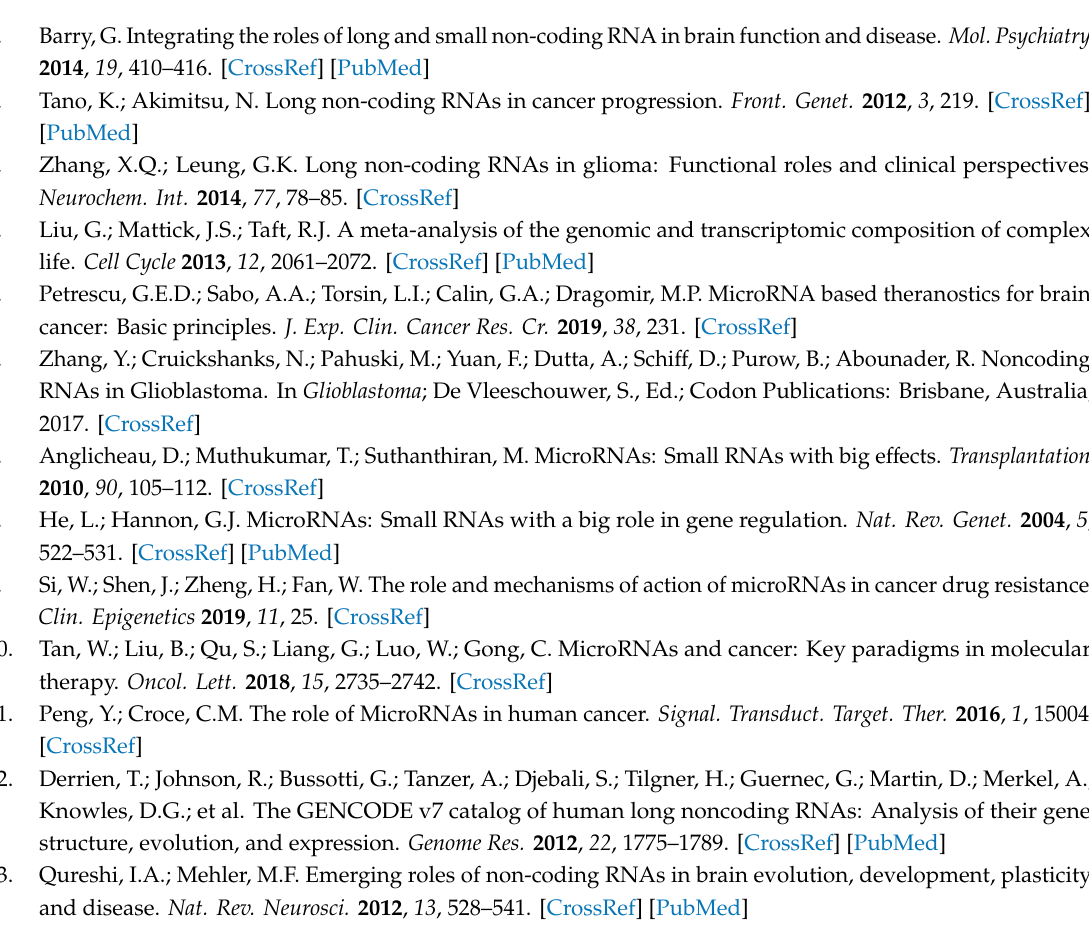
Figure S1: Lnc2Cancer 2.0—lnc—glioblastoma. The file contains information from the lnc2Cancer database about lncRNAs correlated to glioblastoma. Figure S2: Lnc2Cancer 2.0—ln.—drug resist, circulating, prognostic. The file contains information from the lnc2Cancer database about lncRNAs correlated to glioblastoma that are reported as drug resistant, circulating and / or prognostic. Figure S3: Lnc2Cancer 2.0—lnc—meth. The file contains information from the lnc2Cancer database about lncRNAs correlated to glioblastoma that are regulated by methylation. Figure S4: Lnc2Cancer 2.0—lnc—score. The file contains information from the lnc2Cancer database about lncRNAs correlated to glioblastoma that are experimentally